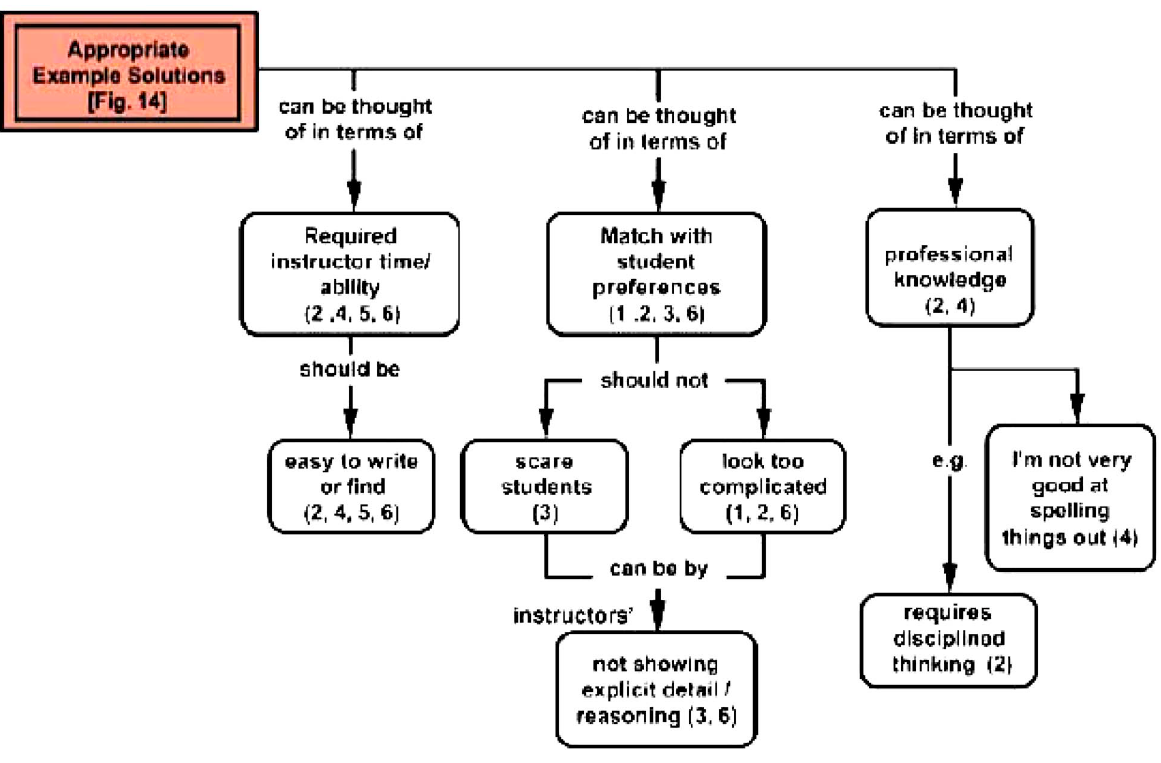
FIG. 14. (cid:1) Color (cid:2) Constraints part of composite map “Appropriate Example Solutions” concerned with faculty beliefs about the appro- priate structure of example solutions in their introductory physics course. Numbers in the parentheses denote the instructor whose statements directly justify that